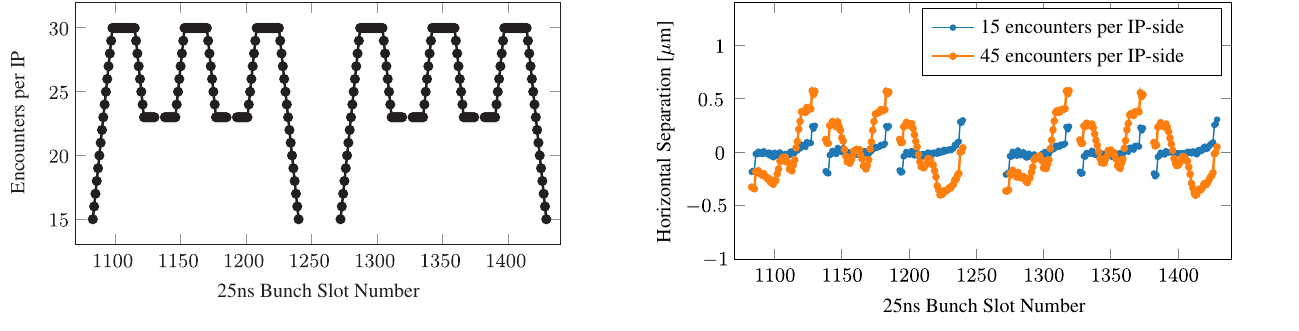
FIG. 15. Number of long-range beam-beam encounters in the drift space and inner triplets around ATLAS and CMS for two trains of the 2556 bunch filling scheme used in 2017 LHC operation. The pattern is identical for all trains.